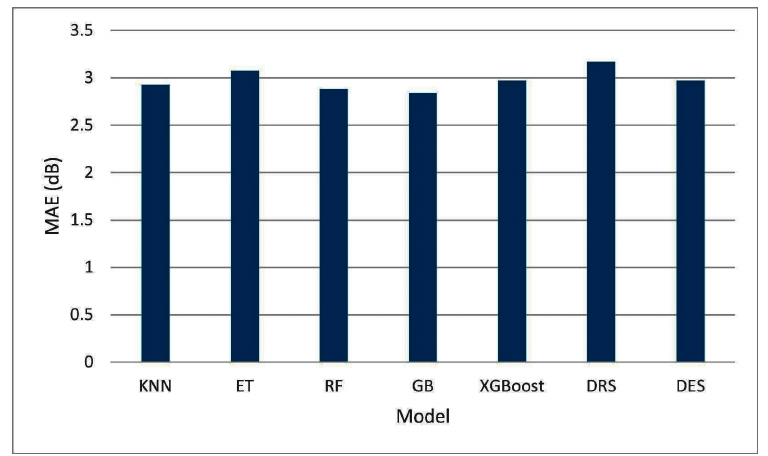
Figure 4. Mean Absolute Error values of models based on dataset 1.